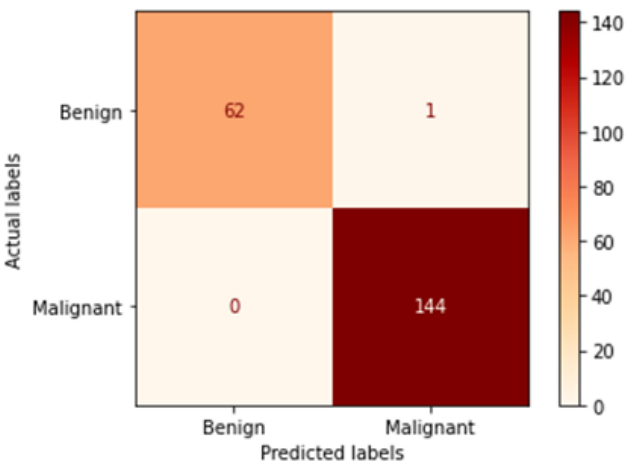
Figure 16. Confusion matrix of Xception model in 100× magnification-dependent binary classifica- tion.